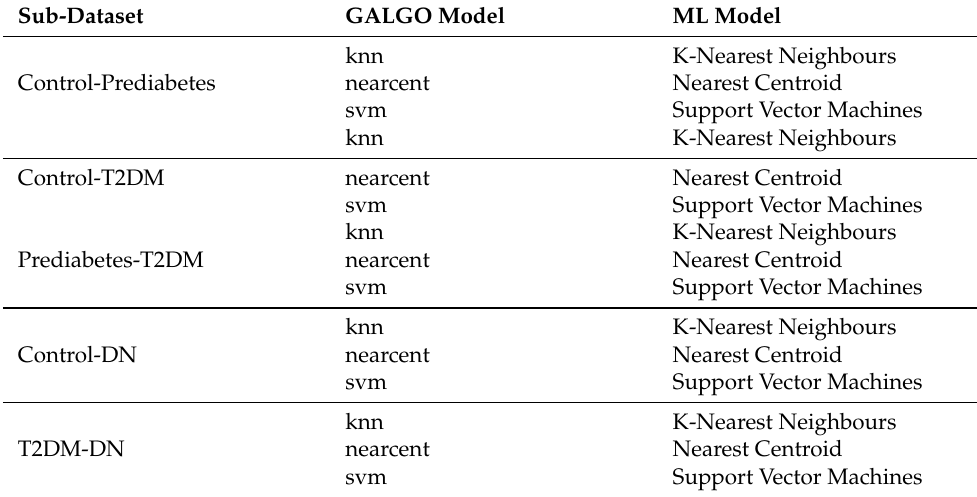
Table 4. GALGO models—ML